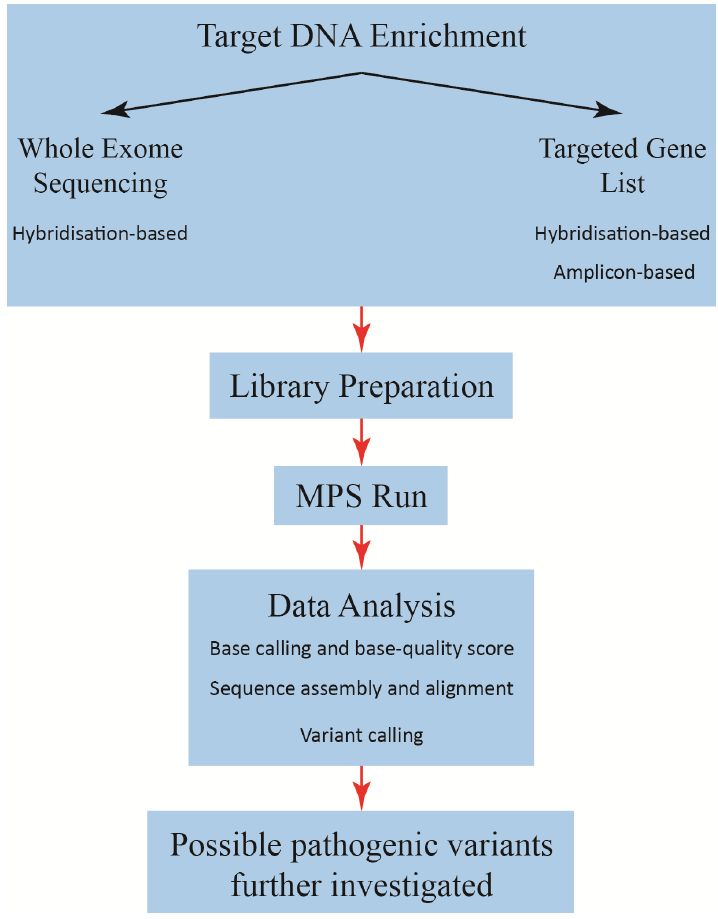
Figure 2. Basic workflow of massively parallel sequencing